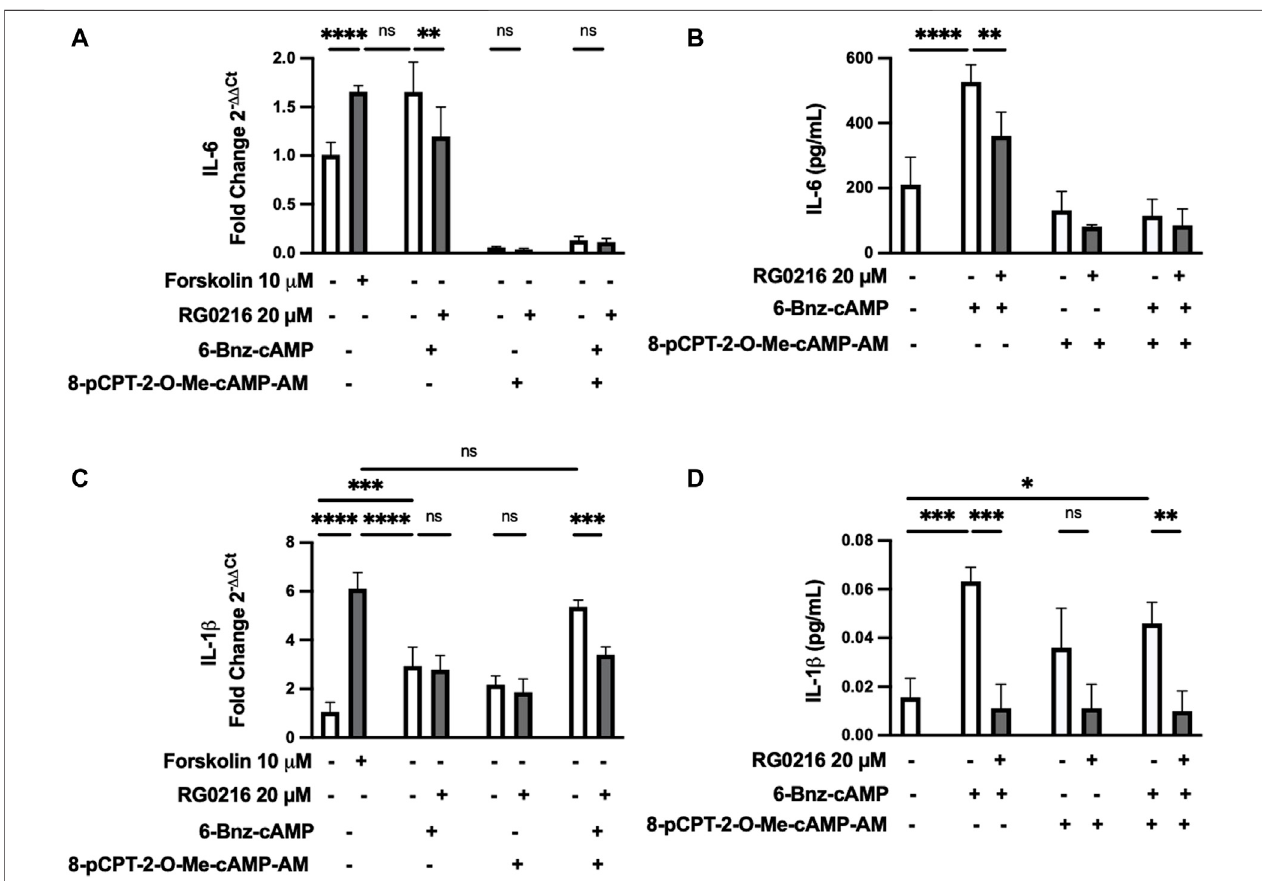
FIGURE6 | IL-6 and IL-1 β gene and proteinexpressions are uniquely upregulated byPKA and EPAC activation but both are decreased by RG0216. (A) IL-6 gene expression was signi fi cantly induced by PKA activation (100 µM 6-BNZ-cAMP). EPAC selective activation (10 µM 8-pCPT-2-O-Me-cAMP-AM) fully inhibits IL-6 expression incontrolsandnegates PKA-induced IL-6expression. RG0216 decreased PKA-induced IL-6geneexpression. (B) RG0216 alsodecreasedPKAactivation- induced effect on IL-6 protein expression. (C) IL-1 β gene expression was partially induced with PKA selective activation but not by EPAC selective activation. Co- stimulation with PKA and EPAC activator induced IL-1 β gene expression and this increase was reduced with RG0216. Forskolin was the positive control. (D) RG0216 reduced PKA/EPAC- and PKA alone-mediated effectson IL-1 β protein expression.EPAC-activation alonehad no effect on IL-1 β protein expression. Datapresentedas mean ± SD (qRT-PCR, n (cid:2) 5, protein, ≥ 3). ns, not signi fi cant, * p < 0.05, ** p < 0.01, *** p < 0.001 and **** p <